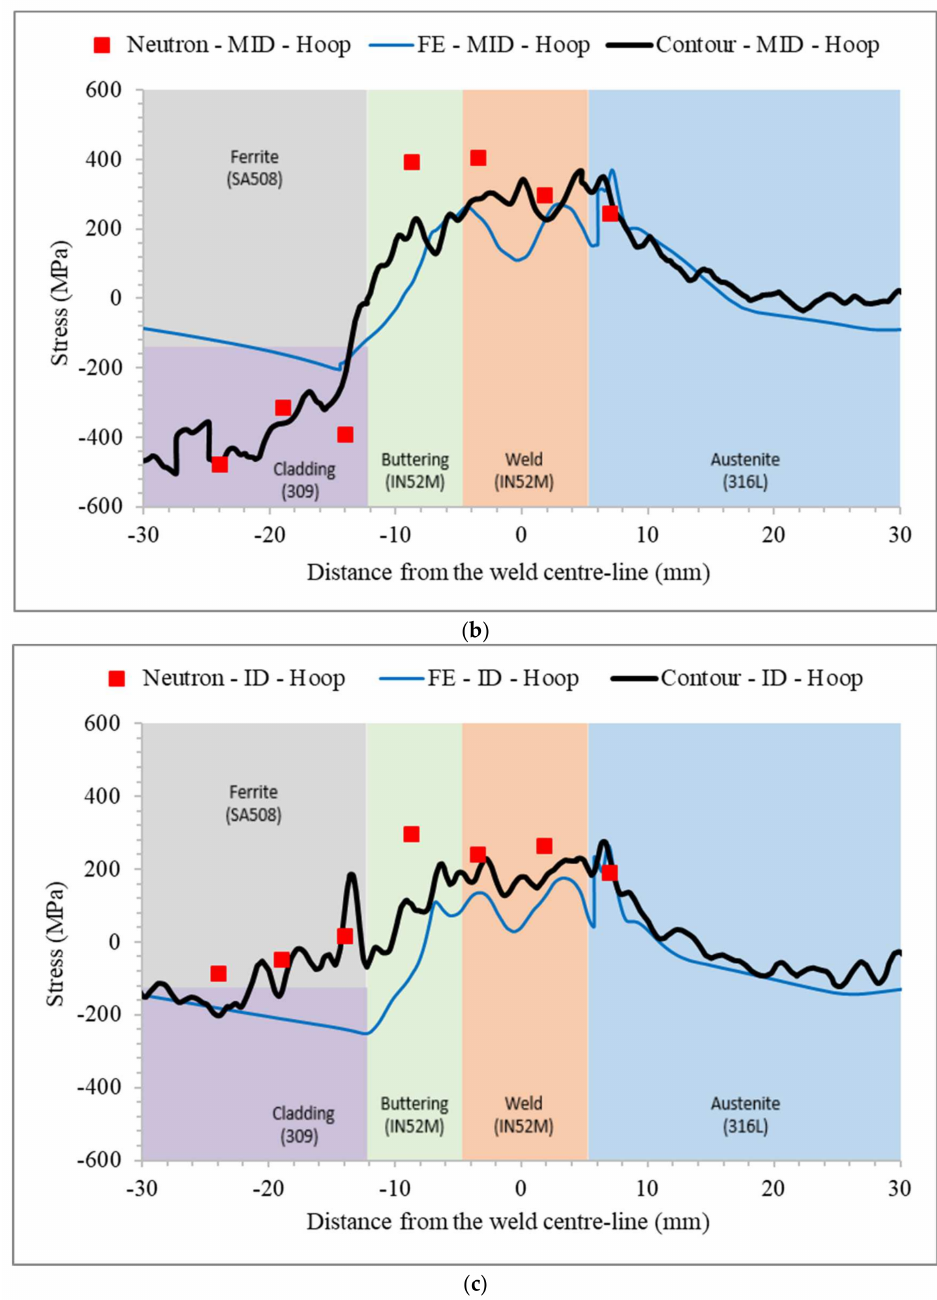
Figure 14. Comparison of hoop residual stresses along the three paths (as defined in Figure 13) between the FE prediction and experimental measurements: ( a ) along path 1 (near OD); ( b ) along path 2 (mid-wall); ( c ) along path 3 (near